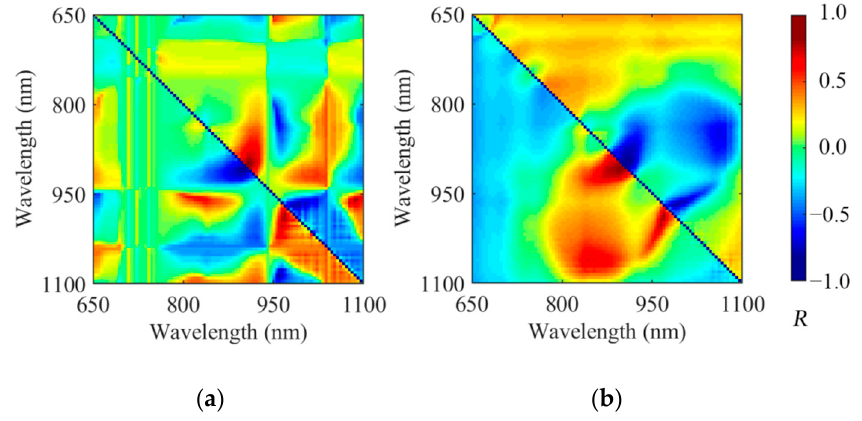
Figure 6. The spectral correlation after ( a ) orthogonal spatial projection combined with spectral ratio (OPS-SR) and ( b ) linear regression correction combined with spectral ratio (LRC-SR).